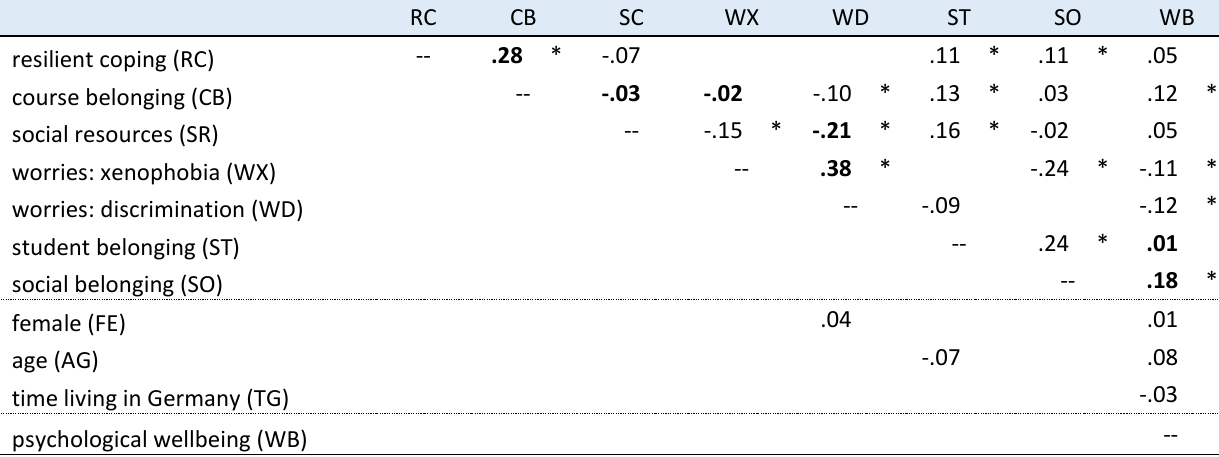
Refugee Students’ Psychological Wellbeing, Direct Effects